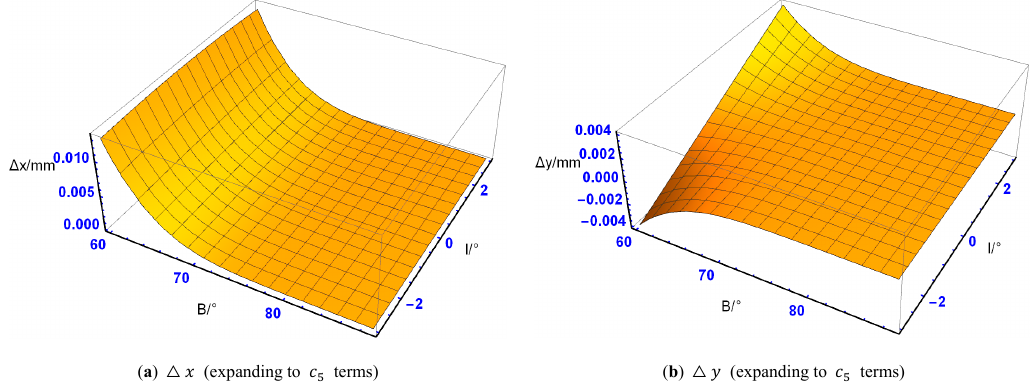
Figure 12. The distribution of (△ 𝑥,△ 𝑦) when expanding to 𝑐 (cid:2873) terms (based on 𝑒 ).